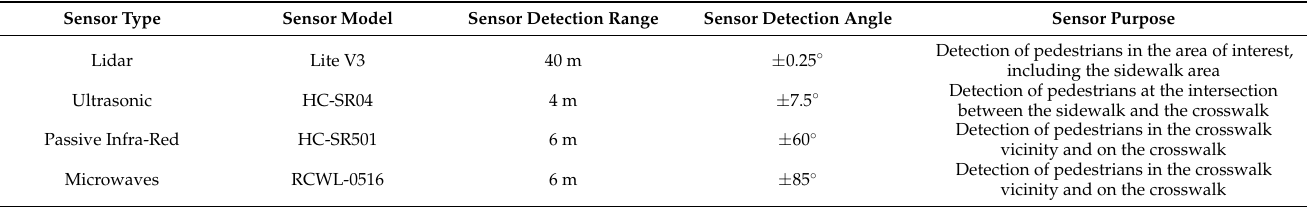
Table 1. Summary of the sensors tested for pedestrian detection, sensors characteristics, and sensors